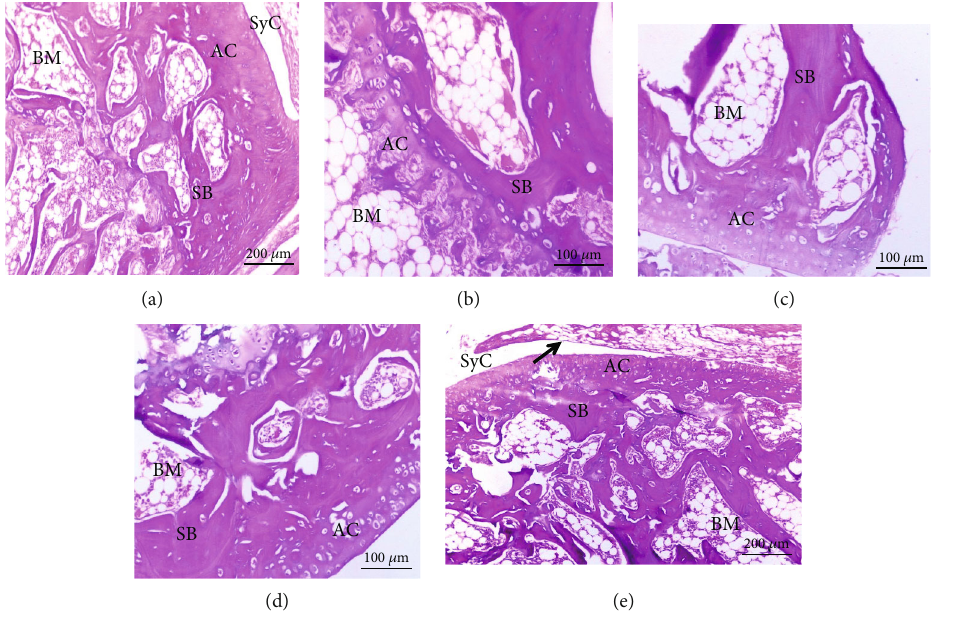
Figure 4: Photomicrographs of sections in the ankles of female rats from control groups: (a, b) water; (c) CMC; (d) curcumin; (e) stem cells showing normal articulating cartilage (AC), synovial cavity (SyC), synovial membrane ( ↗ ), sponge bone (SB), and bone marrow